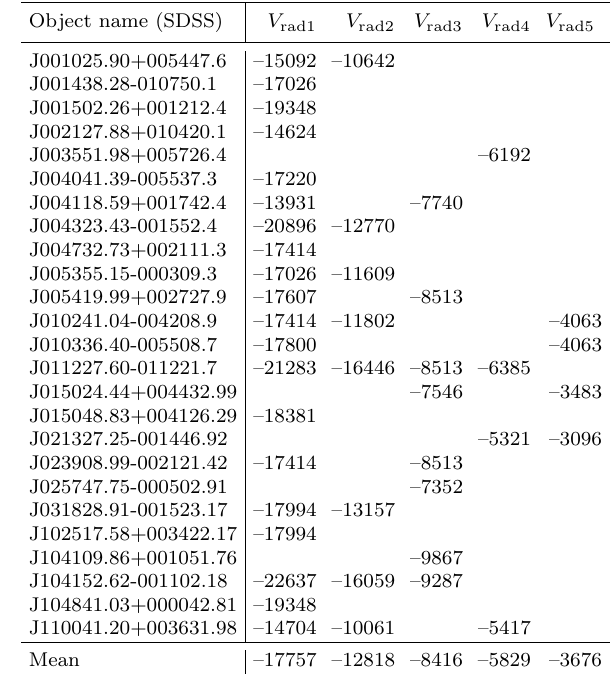
Table 1. Radial velocities